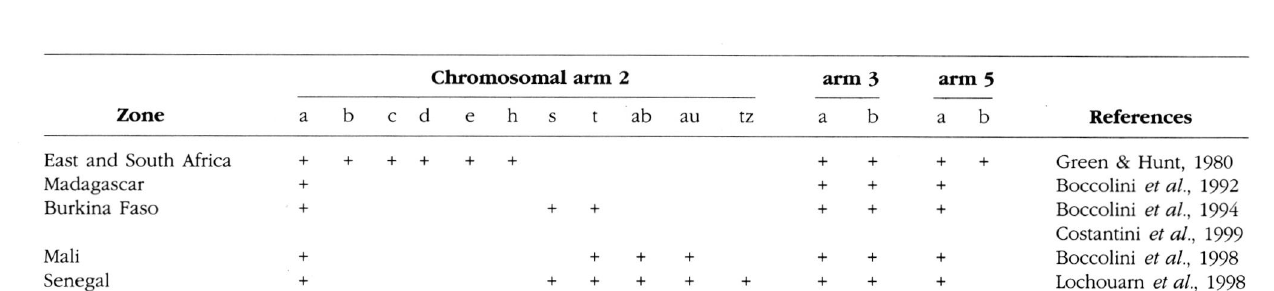
Table V. - Summary of the different inversions described in An. funestus from South and East Africa, West Africa and Madagascar island.